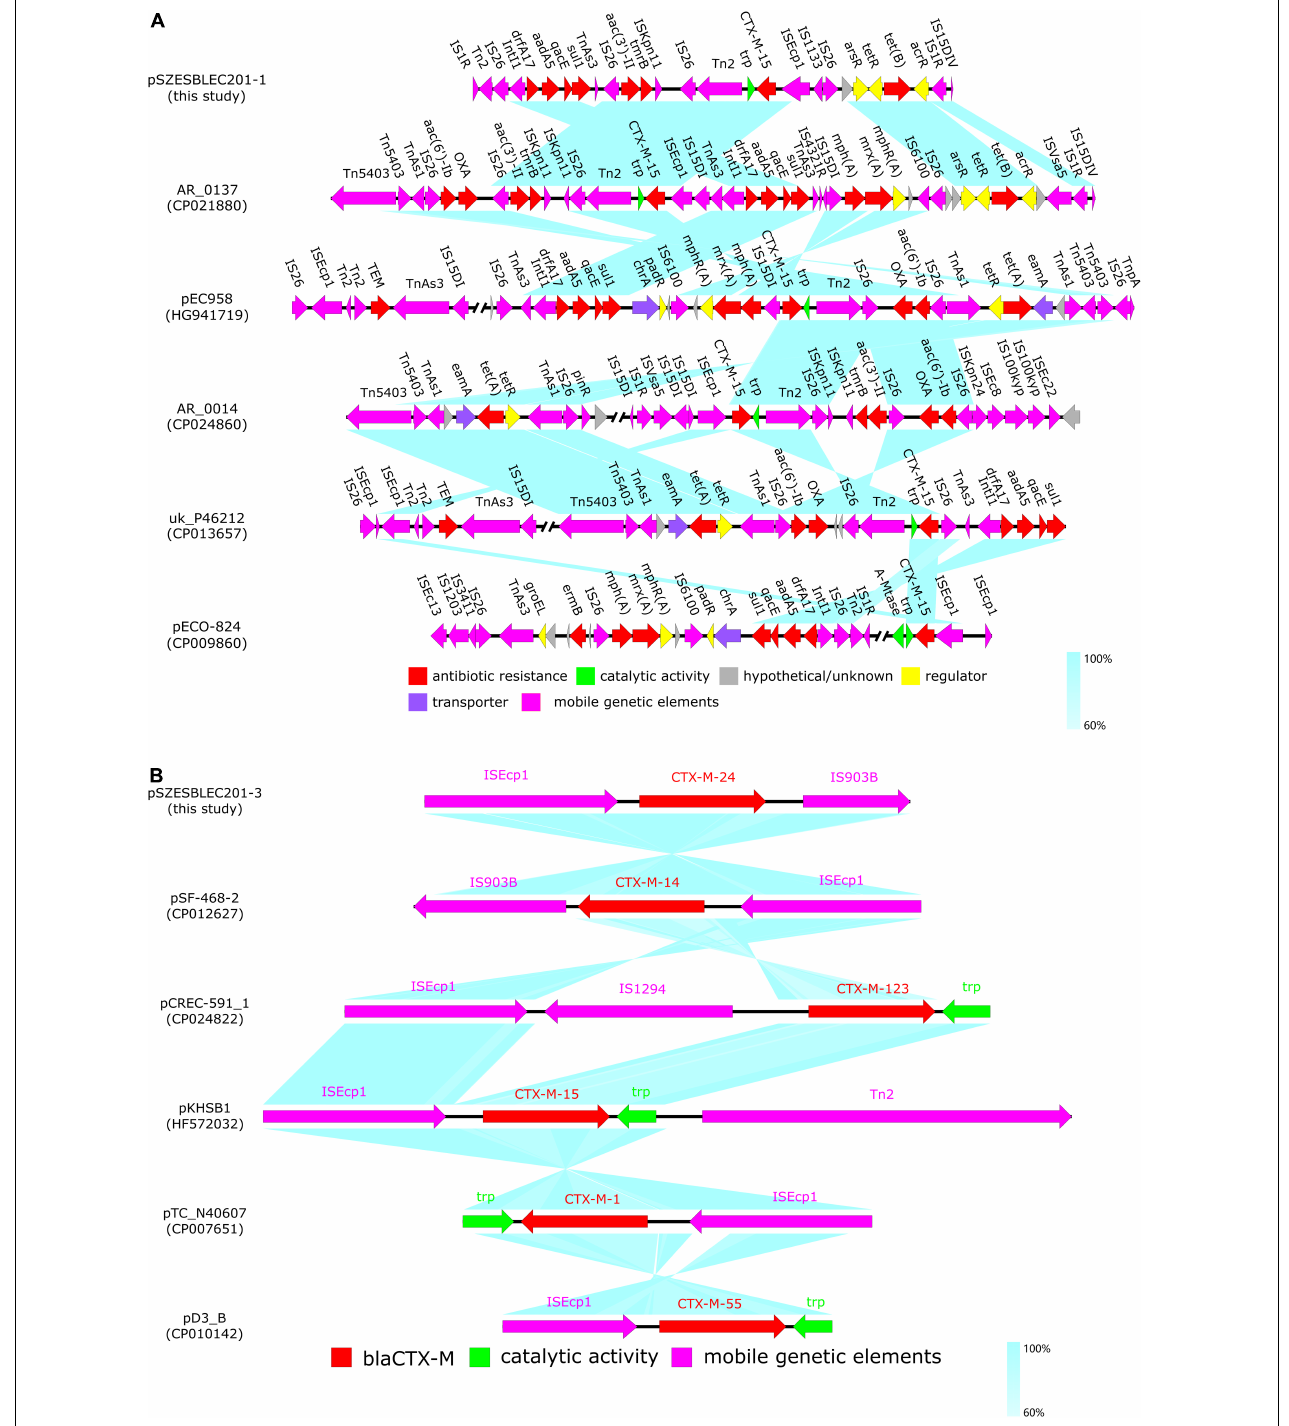
FIGURE 5 | Linear comparison of pSZESBLEC201-1 and pSZESBLEC201-3 resistance regions with those of their closest related plasmids. (A) Comparison of pSZESBLEC201-1 MDR region with those of plasmids AR_0137, pEC958, AR_0014, uk_P46212, and pECO-824. (B) Comparison of the genetic environment surrounding bla CTX - M in pSZESBLEC201-3, pSF-468-2, pCREC-591_1, pKHSB1, pTC_N40607, and pD3_B. Open reading frames are indicated with arrows. Homologous regions in different plasmids are linked with turquoise coloring, and degrees of homology are denoted by color depth. Red, bright green, gray, yellow, purple, and fuchsia represent genes associated with antibiotic resistance, catalytic activity, hypothetical proteins, regulation, transportation, and mobile genetic elements, respectively.